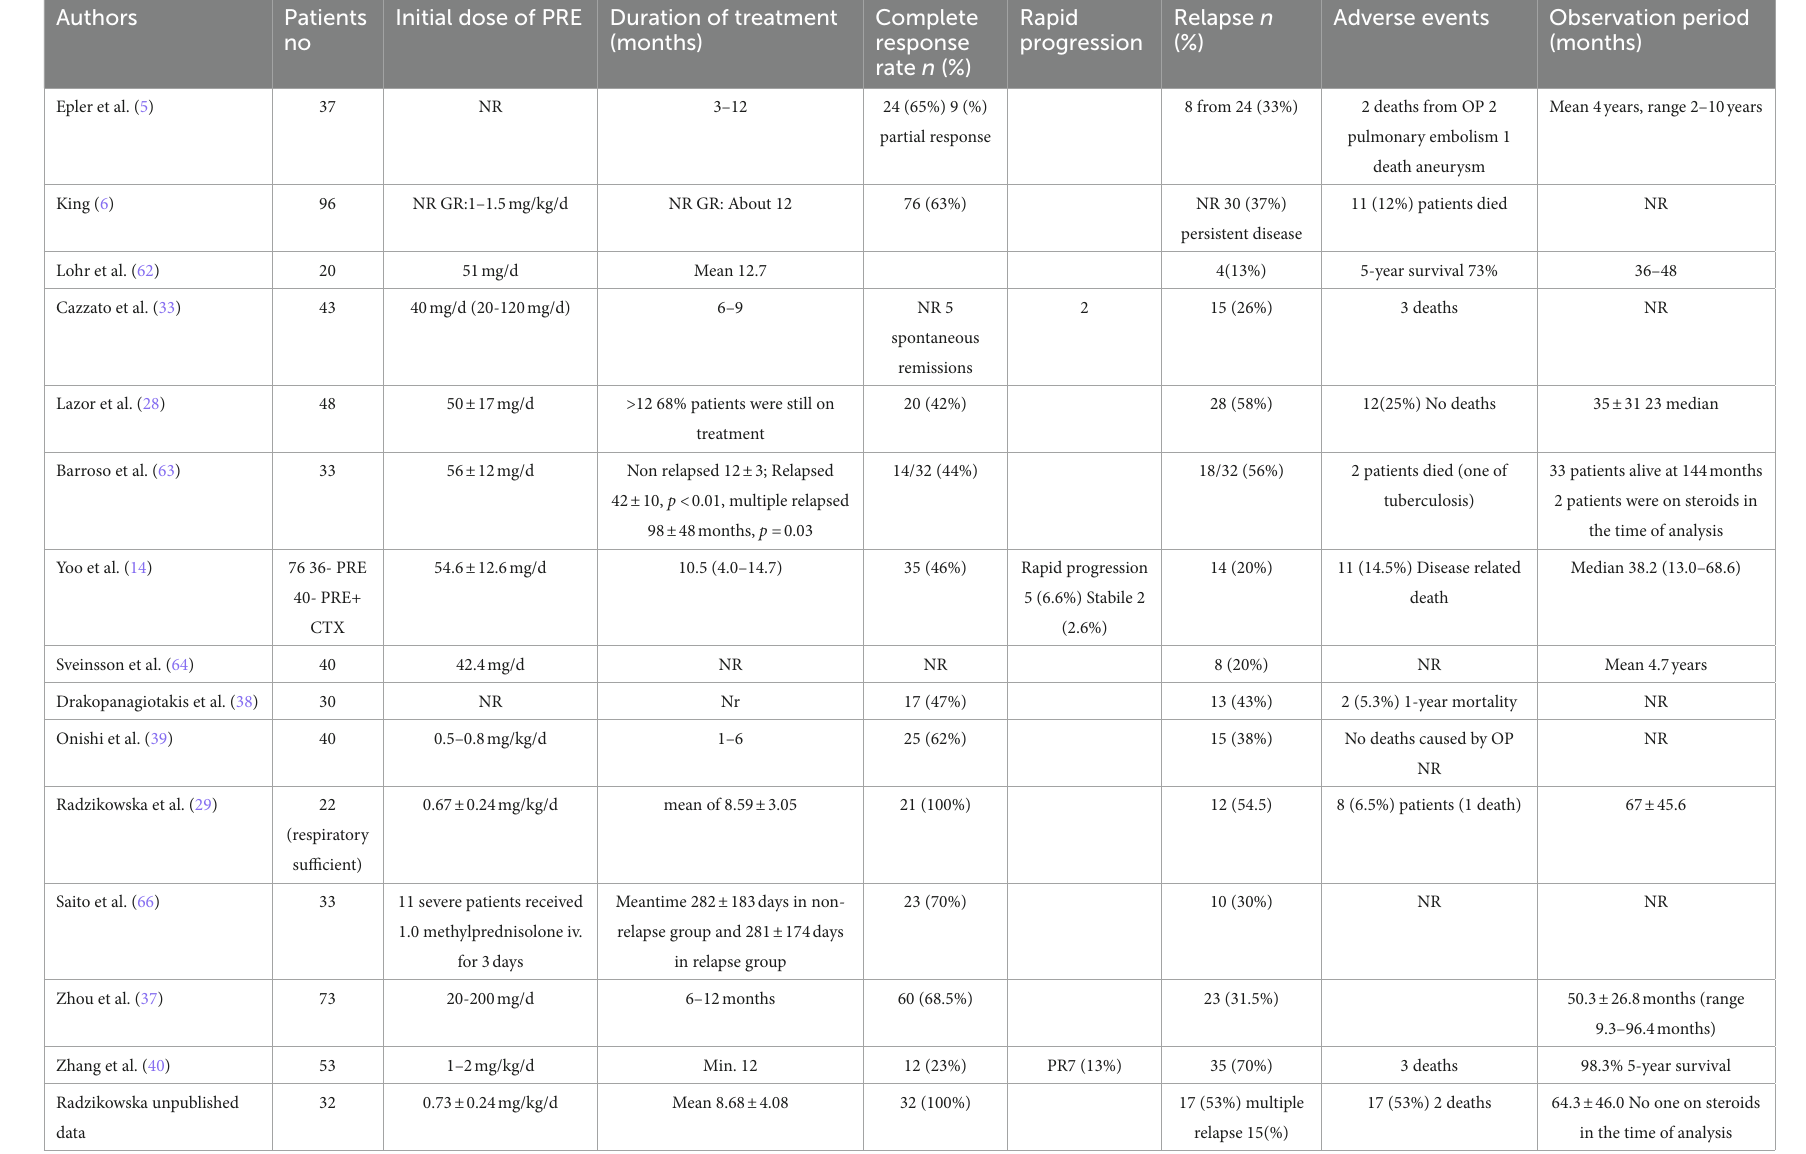
TABLE 5 COP treatment with corticosteroids – observational retrospective studies of cohorts over than 20 patients (COP patients were extracted from presented